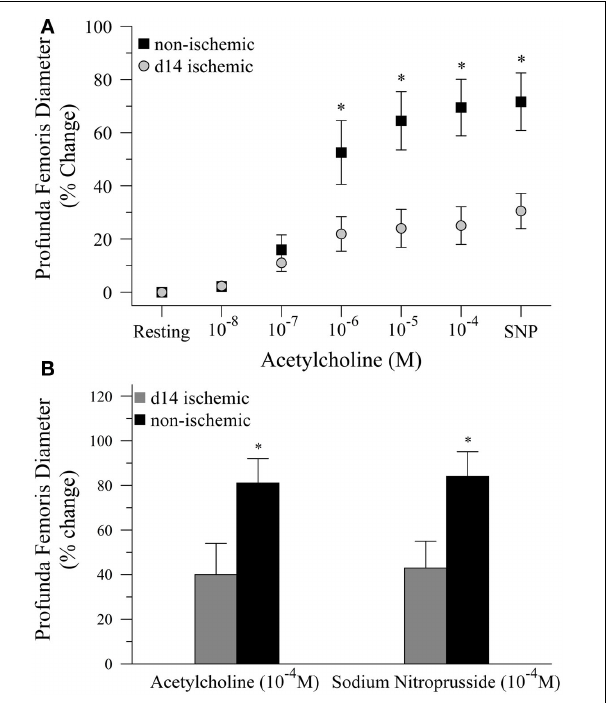
FIGURE 2 |Vasodilation responses to endothelial- and smooth muscle-dependent dilating agents in ischemic and non-ischemic profunda femoris arteries, in vivo . (A) Vasodilation responses to increasing doses of acetylcholine (Ach), applied in 10 − x M increments, and a maximal dose of sodium nitroprusside (SNP) in day-14 ischemic (gray) and non-ischemic (black) arteries. (B) Vasodilation responses to maximal doses of Ach (10 − 4 M) and SNP (10 − 4 M) in day-14 ischemic (gray) and contralateral control (black) profunda femoris arteries. Data points are on a relative scale, with resting diameter represented by 0%. ∗ p ≤ 0.05 versus day-14